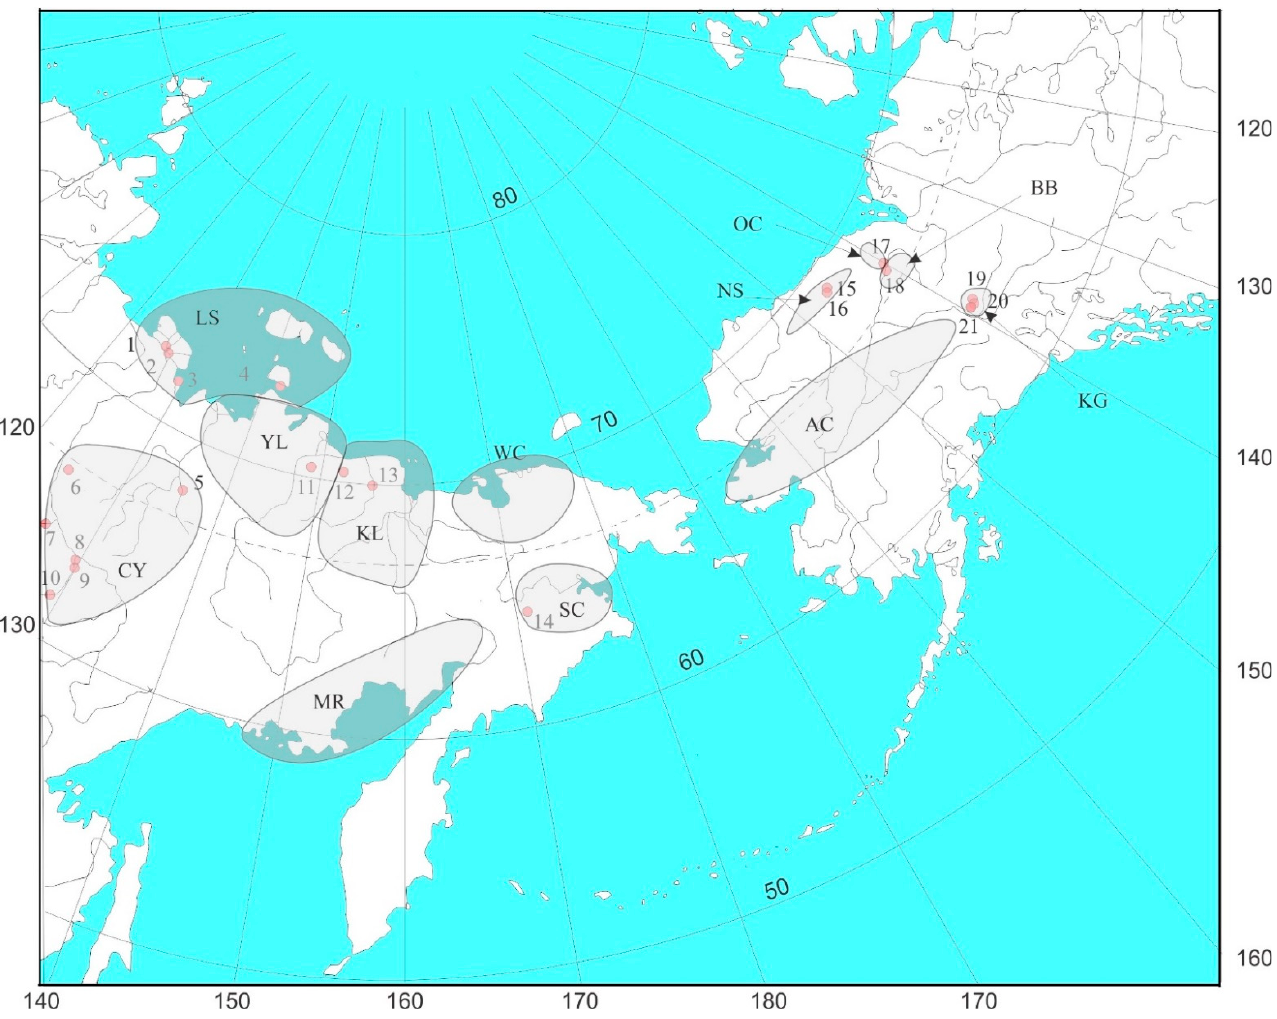
Figure 2. Map of Beringian regions East Beringia: AC—Alaska, Central and East; BB—Bluefish River Basin and Porcupine River; ER—Eagle River, KG Klondike Gold Field, NS—North Slope of Alaska, OC—Old Crow River. West Beringia: CY Central Yakutia, KL—Kolyma Lowland, LS—Laptev